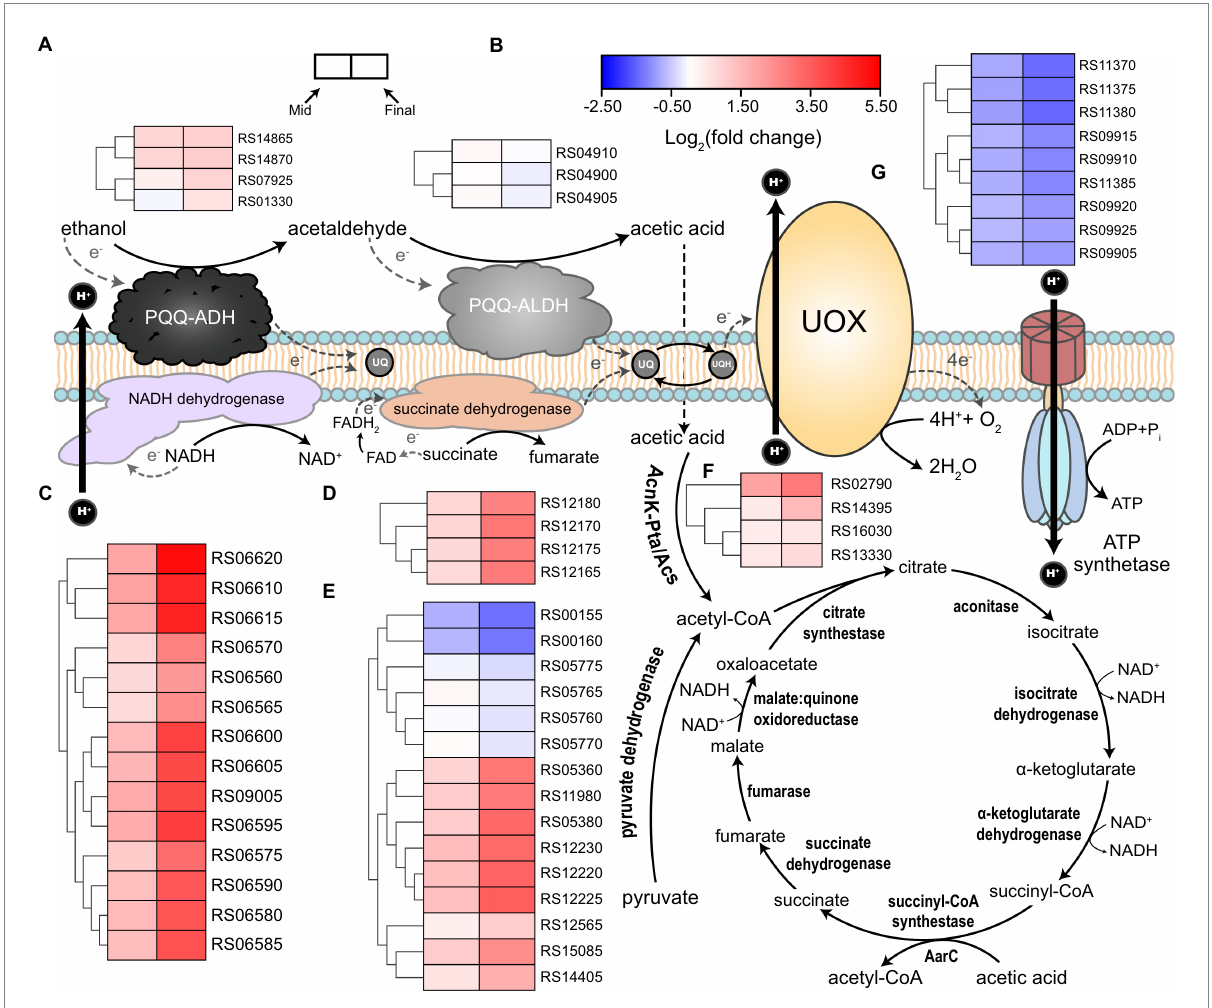
FIGURE 4 Illustration of respiratory chain and tricarboxylic acid (TCA) cycle together with the expression patterns of related genes. Acetic acid bacteria (AAB) cells possess both ethanol respiratory chain, which consists of PQQ-ADH and PQQ-ALDH, and common respiratory chain based on NADH and succinate dehydrogenase. Both respiratory chains deprive electrons from corresponding substrates and transfer them to ubiquinone (UQ), which is consequently reduced to ubiquinol (UQH 2 ). UQH 2 then transfers the electrons to ubiquinol oxidase (UOX) so that to be oxidized back to UQ. Finally, oxygen gains electrons from UOX, and then water is formed. NADH dehydrogenase and UOX are able to utilize the energy released from relevant redox reactions to expel protons out of the cells, generating proton motive force that can be used to yield ATP by ATP synthetase. Acetic acid produced by the ethanol respiratory chain from the incomplete oxidation of ethanol can penetrate into the cells and then is transferred to acetyl-CoA, which can be conducted either by the combination of acetate kinase (AckA) and phosphotransacetylase (Pta), or acetyl-CoA synthetase (Acs), or AarC. These processes enable acetic acid to enter TCA cycle and therefore act as a carbon source. Gene expression patterns (heatmap) together with the corresponding gene ID are present besides the relevant components or metabolic pathways, in which, (A)